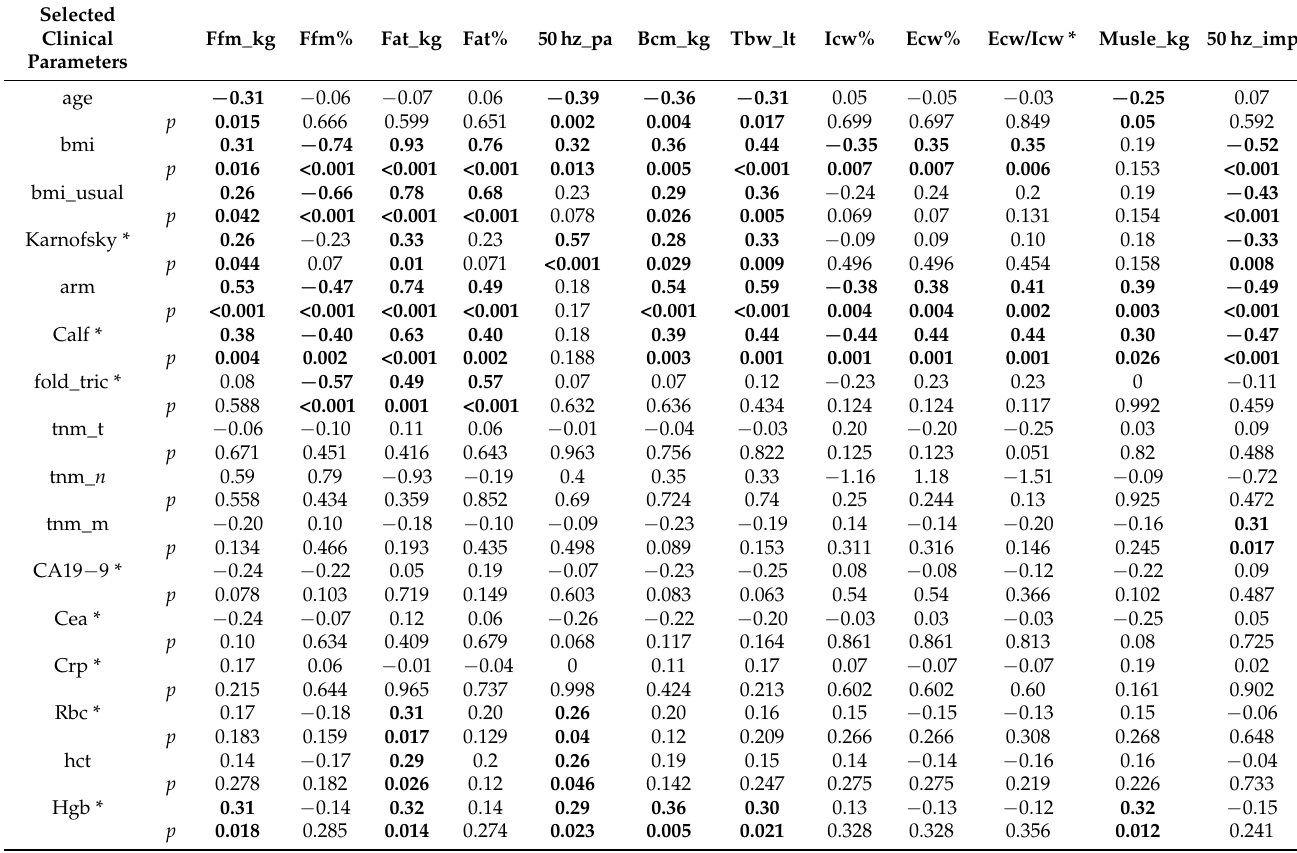
Table 4. Correlations between body composition and other parameters and differences in body composition parameters depending on tumor